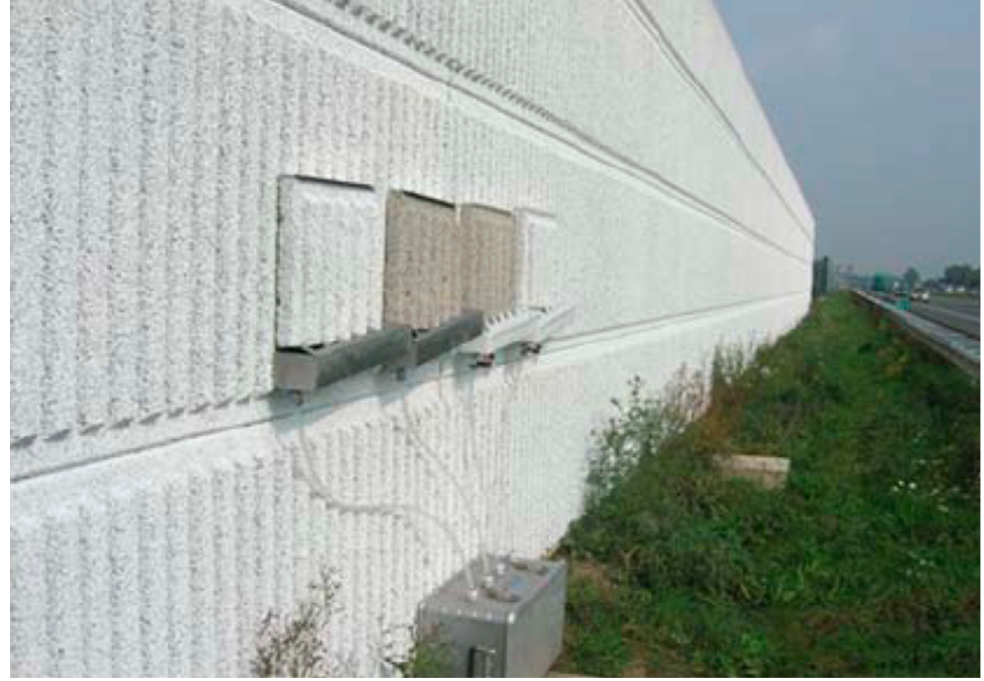
Figure 51. Example of a TiO 2 -coated concrete noise barrier erected along the A1 and A28 highways in Terschuur and Putten, the Netherlands. Reproduced from Ref. [152].